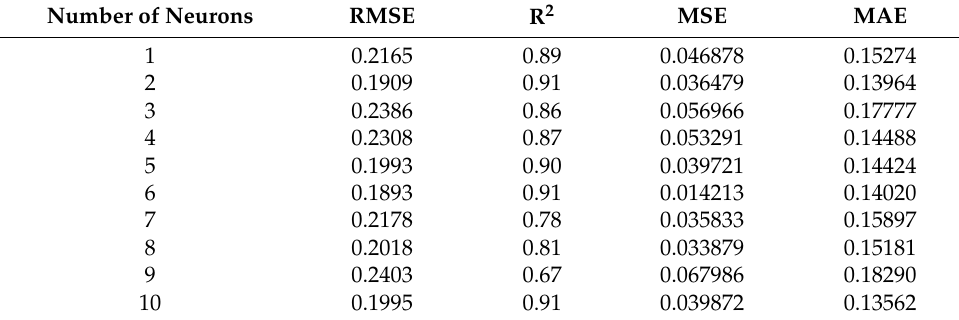
Table 4. Neural network performance based on training